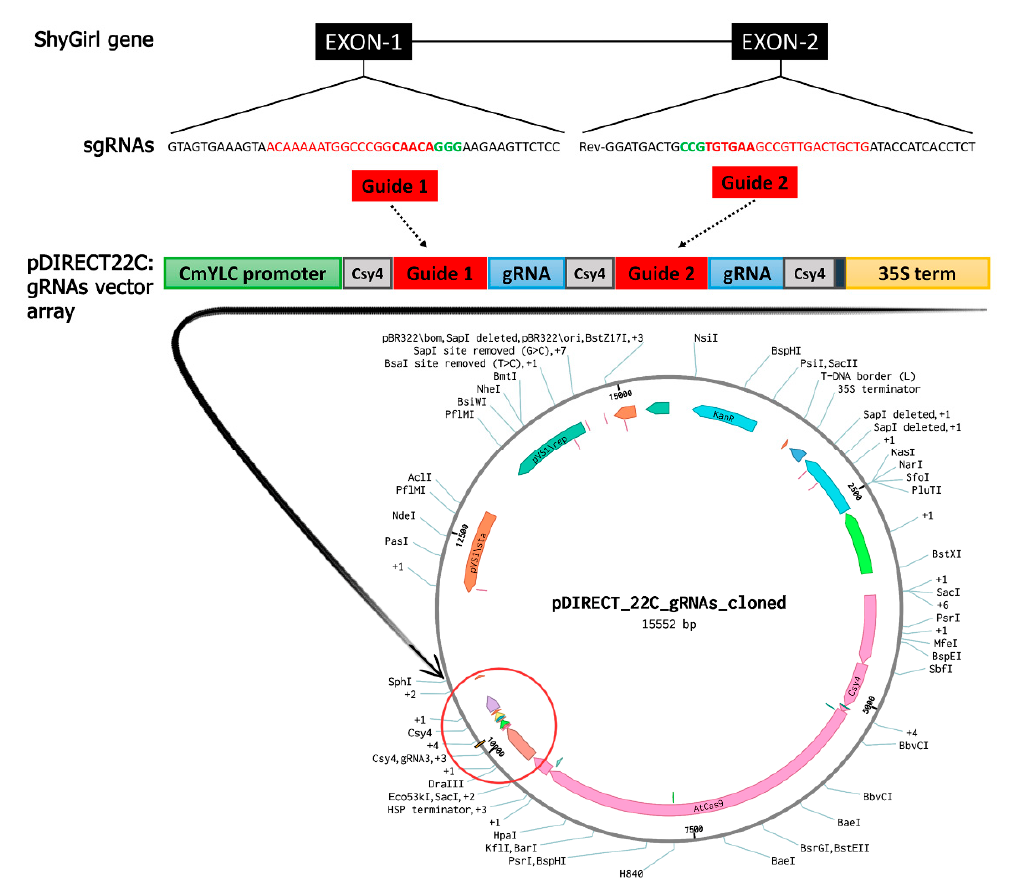
Figure 1. Diagram of the Cas9/sgRNA p DIRECT22C vector and target site selection in the SyGI gene. Above, the SyGI gene is schematically represented: the black boxes represent the two exons of the gene connected through the line, which represents the intron. The sequence of two sgRNAs selected on the first and second exon are reported in red. In the center, the structure of the final p DIRECT22C :gRNA vector cassette is represented with the two cloned sgRNAs (red boxes): the green box represents the CmYLC promoter, the three grey boxes represent the Csy4 repeat, blue boxes represent the gRNA repeat sequences, and the yellow box represents the 35S terminator. Below, the final p DIRECT22C :gRNA vector containing 35S: Csy4 -P2A-AtCas9 + CmYLCV :gRNAs with Csy4 spacers, Plant Selection: 2x35S:npt II. The sgRNA cloning site is circled in